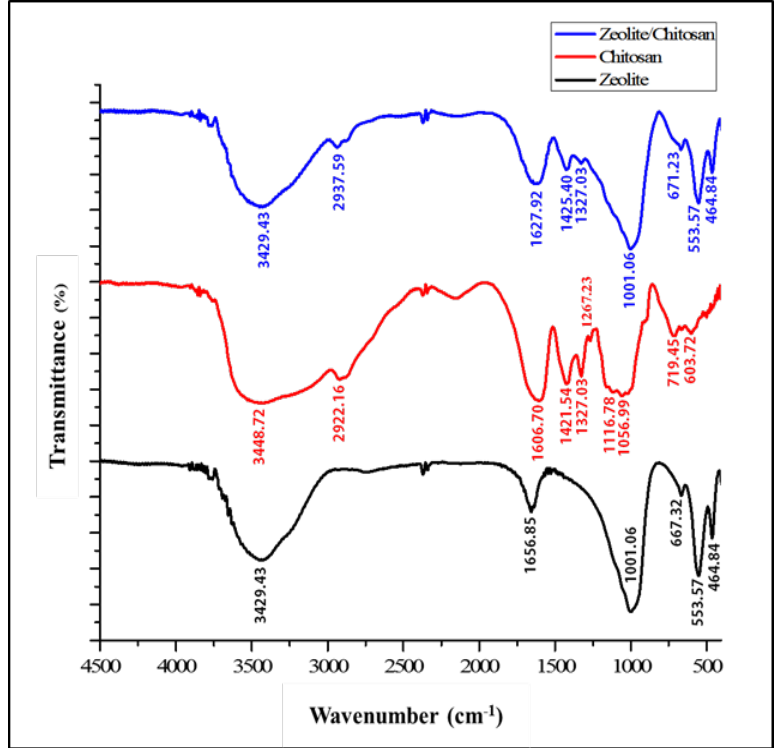
Figure 3. FTIR spectra of zeolite, chitosan, and zeolite/chitosan